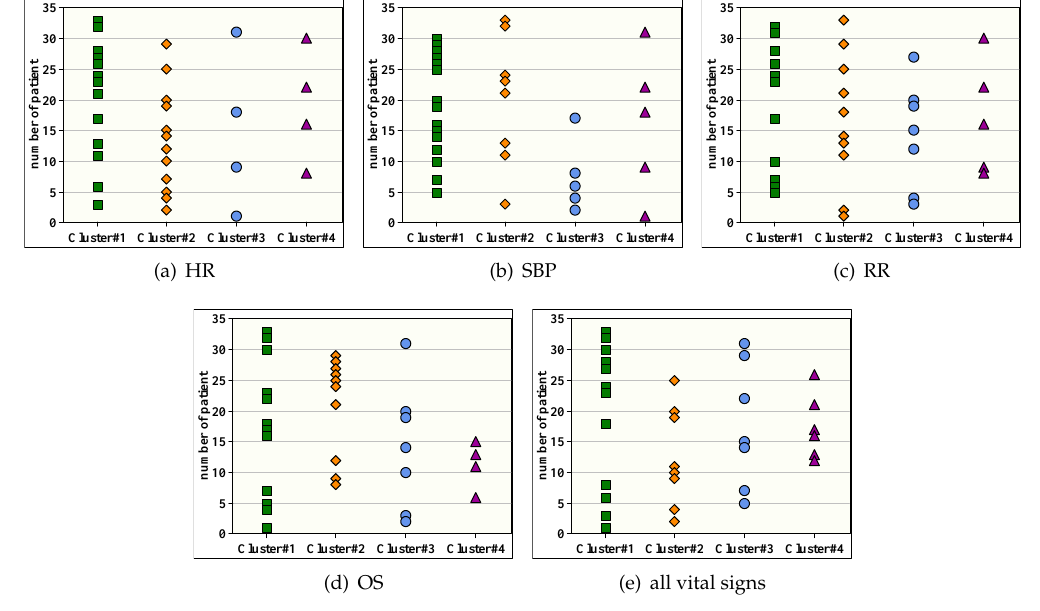
Figure 6. Illustrative example for distribution of patients’ IDs over